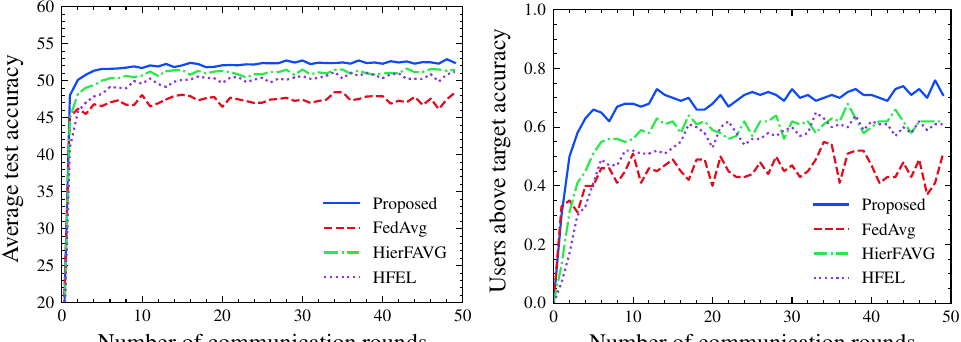
Figure 5. Performance comparisons of the various FL algorithms in Shakespeare dataset.